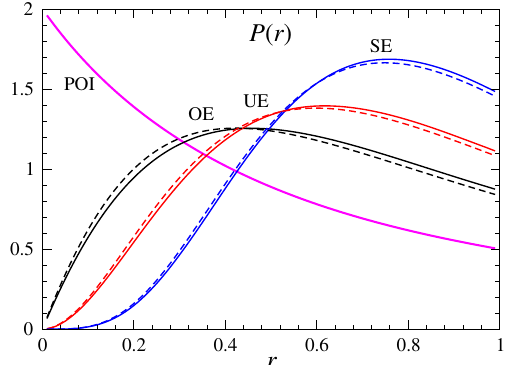
FIG. 8. The distribution P ð r Þ in the Gaussian and circular ensembles of random matrix theory and for a sequence of Poisson distributed random numbers. The label POI refers to Poisson, while the labels OE, UE, and SE refer to orthogonal, unitary, and symplectic ensembles, respectively. Continuous lines depict results for the Gaussian ensembles, while dotted lines depict results for the circular